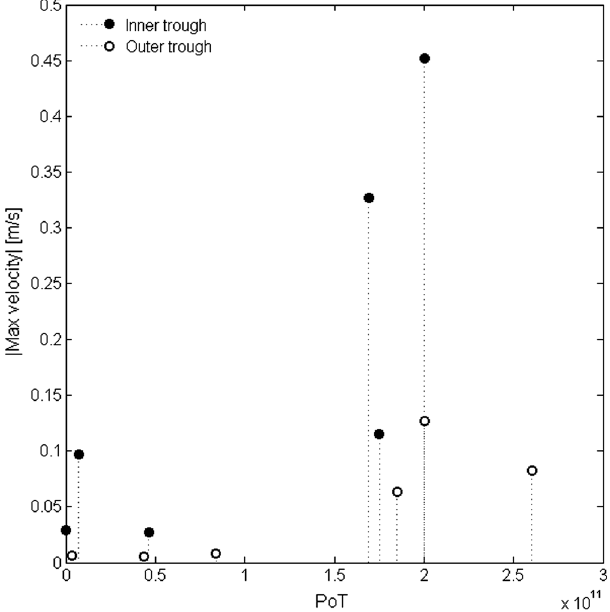
FIG. 14. LDV data of trough surface velocity as a function of beam